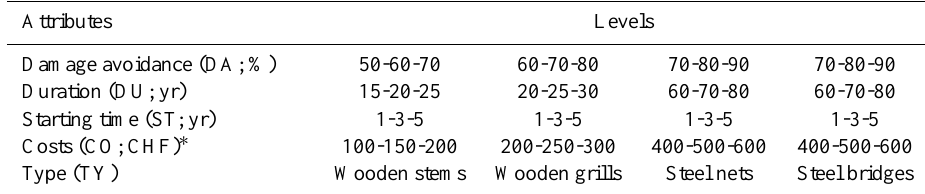
Table 1. Choice experiment attributes with numerical and categorical levels.